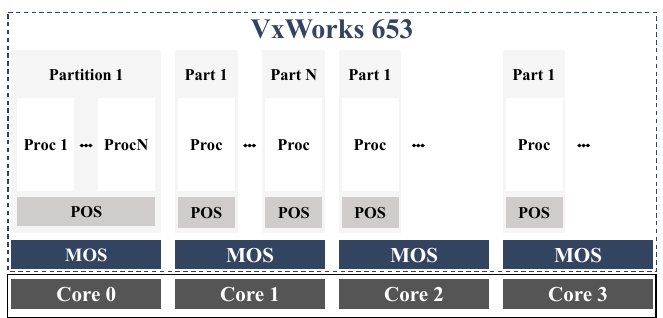
Figure 6. The architecture of VxWorks